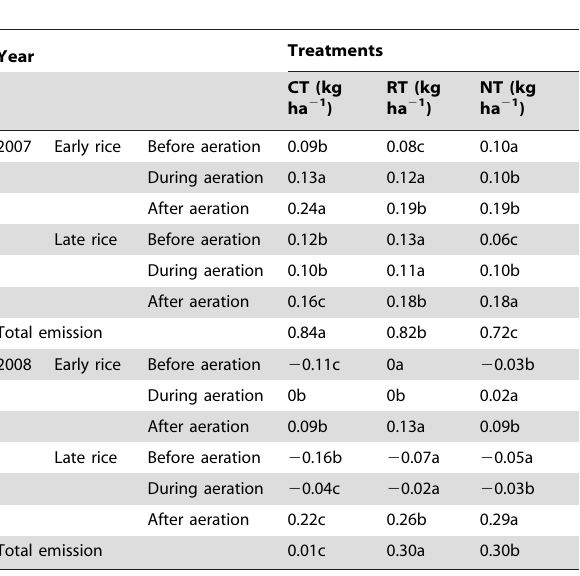
Table 3. Cumulative N 2 O emissions of each farm operation phase during the rice growing